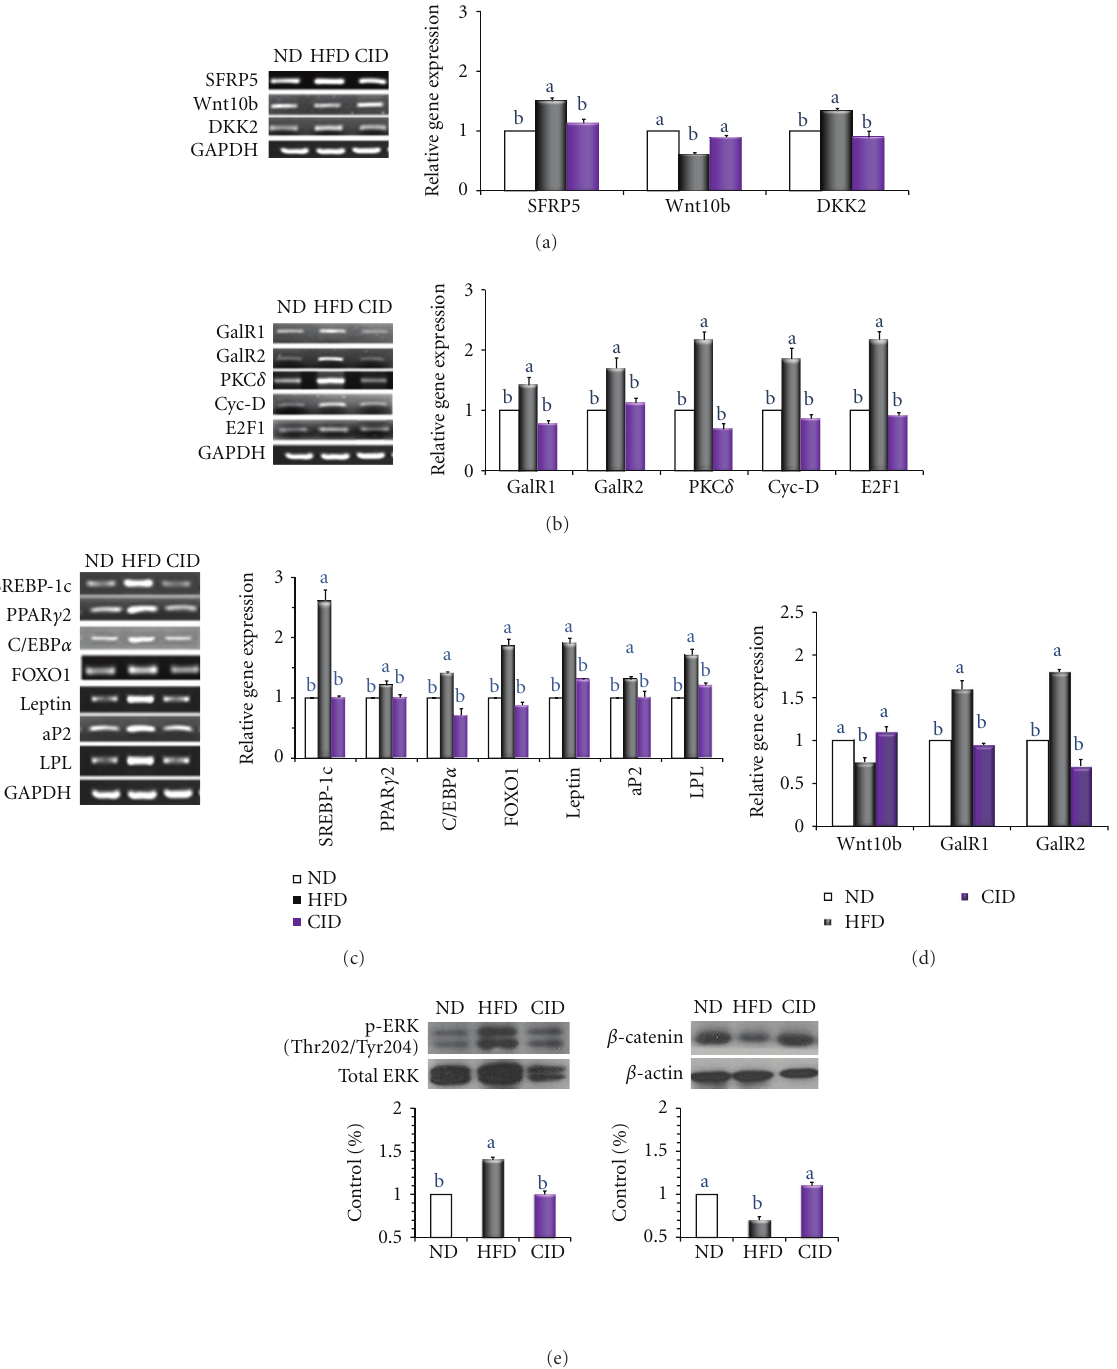
Figure 3: E ff ect of dietary cinchonine on adipogenic genes. Mice were fed on ND, HFD, or CID. (a) The expression of genes related to adipogenesis was determined by a semiquantitative RT-PCR. (b) Expression of galanin and upstream molecules. (c) Expression of transcription factors and target genes. (d) The expression of Wnt10b, GalR1, and GalR2 was determined by a quantitative real-time RT- PCR. The data shown are the relative density normalized to GAPDH. (e) Protein levels of phosphorylation of ERK (p-ERK), total ERK and total β -catenin in the epididymal adipose tissue of mice by Western blot. p-ERK was normalized to their respective total protein level. Total β -catenin was normalized to total β -actin level. Bars represent the mean ± SEM, n = 8, P < 0 . 05. Di ff erent letters are statistically di ff